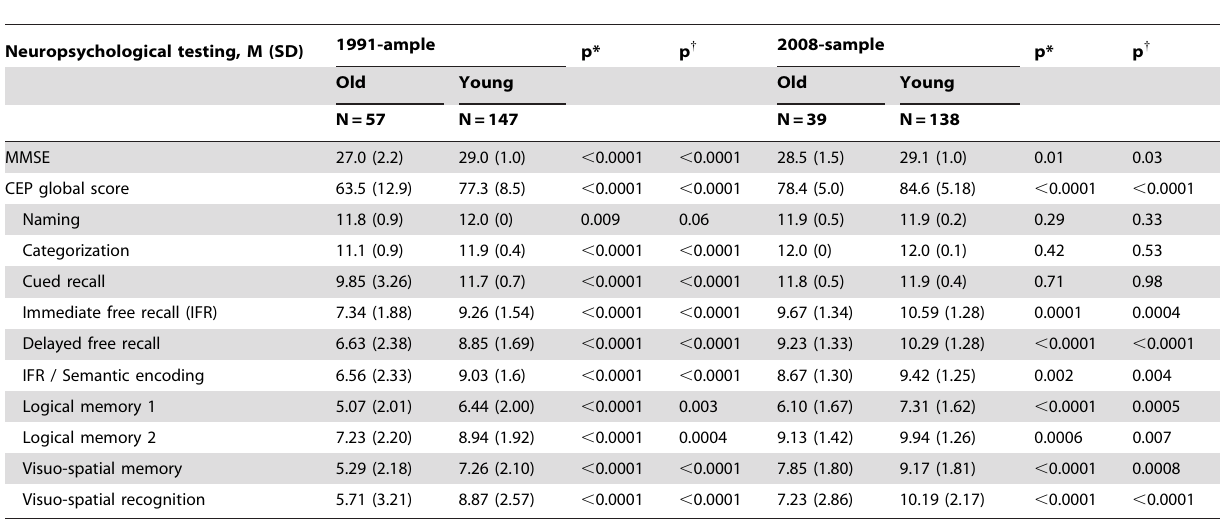
Table 2. Comparison of CEP and sub-scores according to age groups among 1991-and 2008-samples separately.